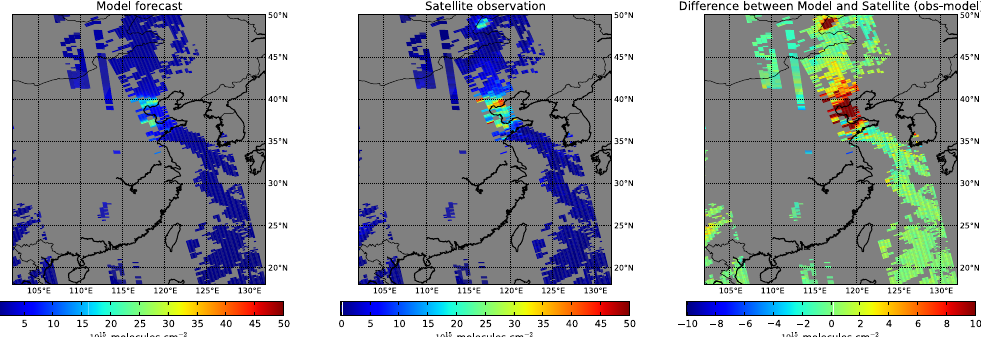
Figure 5. The comparison of the CHIMERE v2013 forecast (left) with OMI satellite observations (middle) on 6 May 2013. The right plot shows the difference between observations and forecast (OmF).